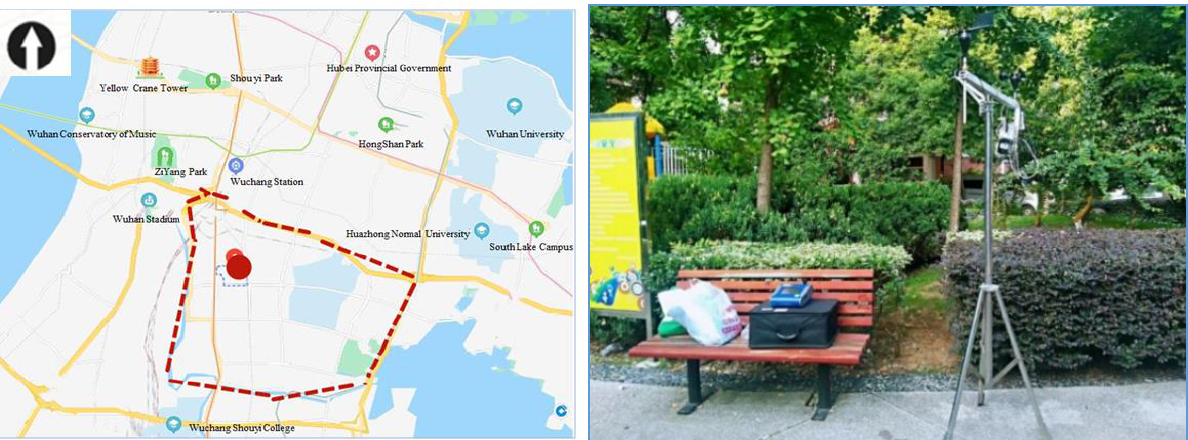
Figure 4. Field measurement sites and photo of measuring instruments.